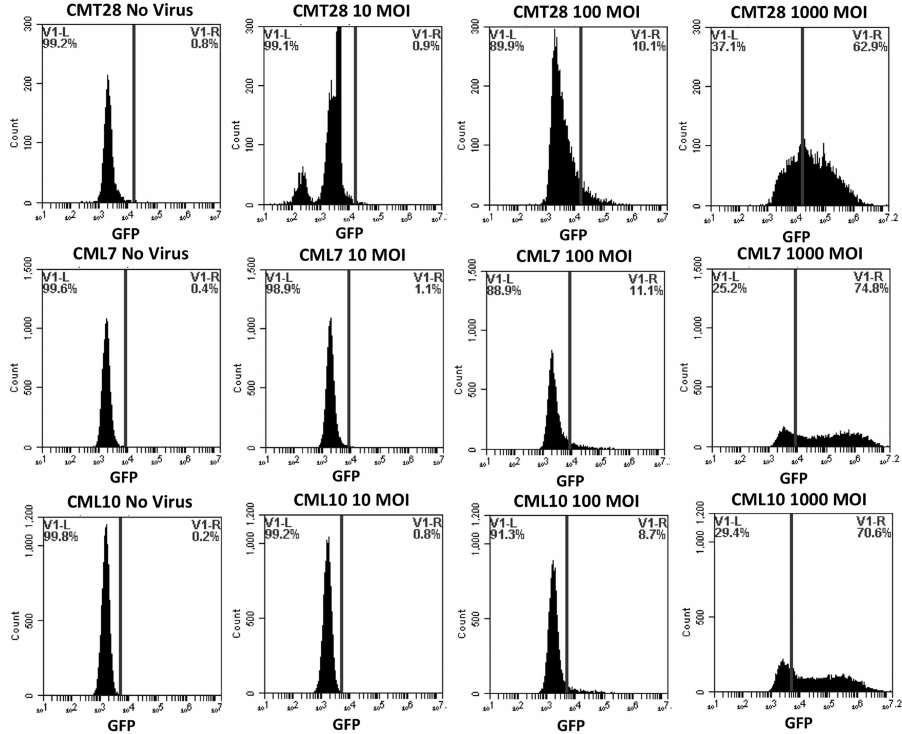
Fig 2. GFP Expression by canine non-hematopoietic origin cancer cells; Canine Mammary Tumor (CMT28), and Canine Melanoma (CML7 and CML10). Cells were transduced by adenovirus Ad5G/L at three different multiplicityof infection(MOI 10, 100, and 1000virus particlesper cell). GFP expressionin cells was analyzedby flow cytometry 48 hours after Ad5G/L